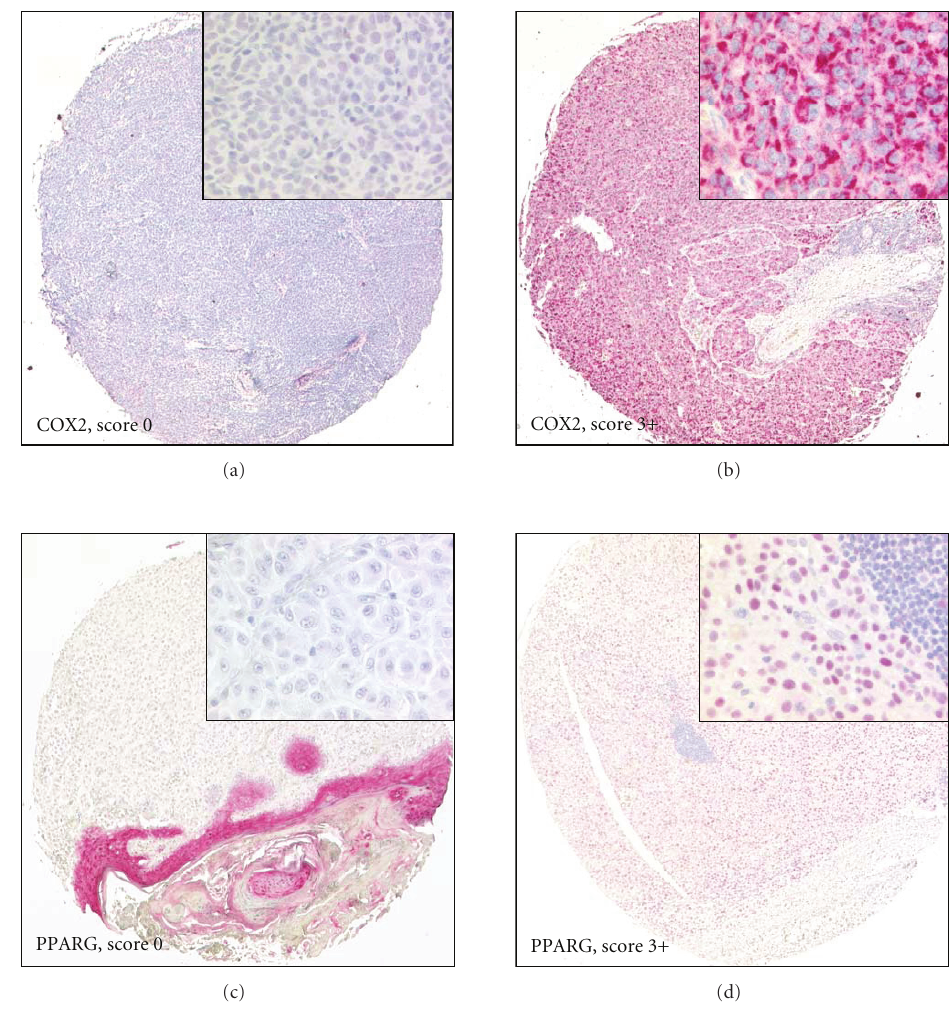
Figure 1: Immunohistochemical COX2 and PPARG staining of malignant melanomas on TMA-2. Original magnification 10x (insets 200x). Representative examples of a primary malignant melanoma with negative (a) and strong (b) immunoreactivity for COX2. Representative examples of a primary malignant melanoma with negative (c) and strong (d) immunoreactivity for PPARG.